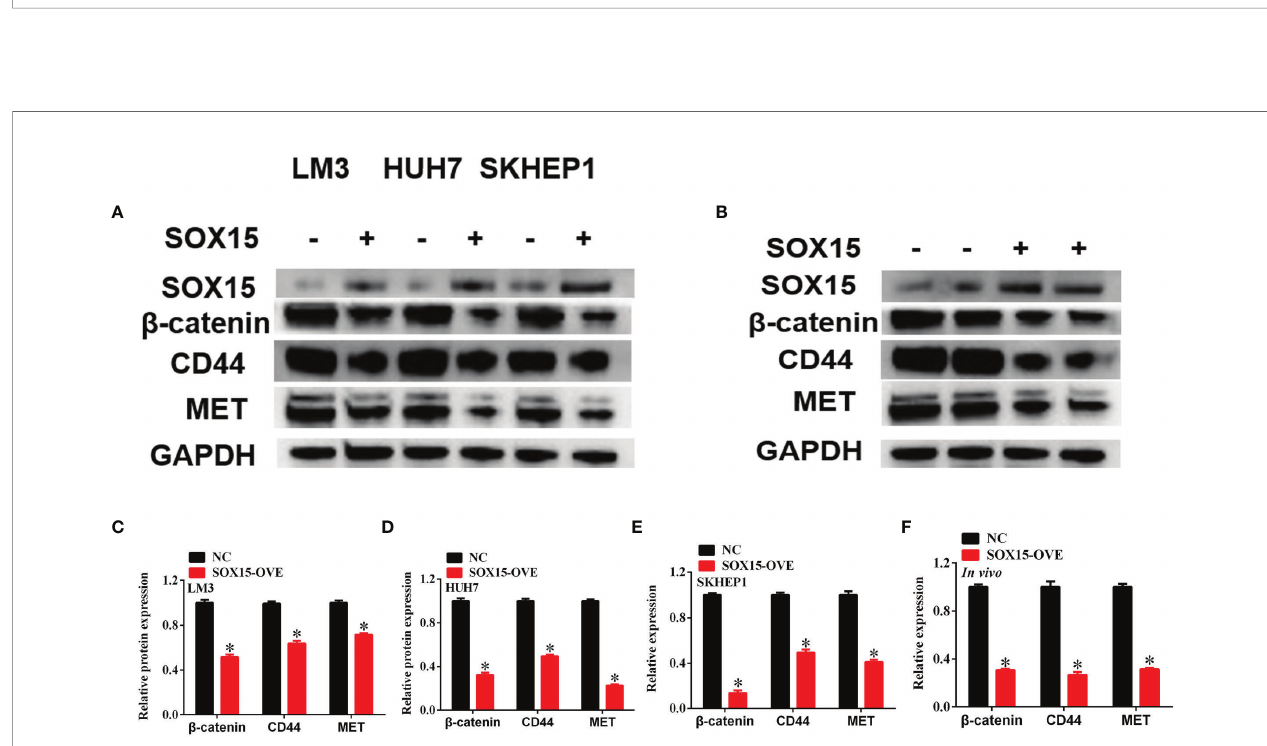
FIGURE 7 | Sox15 inactivates Wnt pathway in HCC. (A – F) The key members of Wnt pathway were measured by western blot after Sox15 overexpression under in vitro (A, C – E) and in vivo (B, F) conditions. *p <